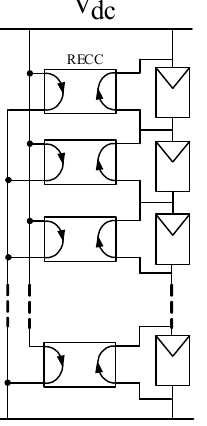
Figure 19. PV string equalized with gyrator-based returned energy current converters [40].